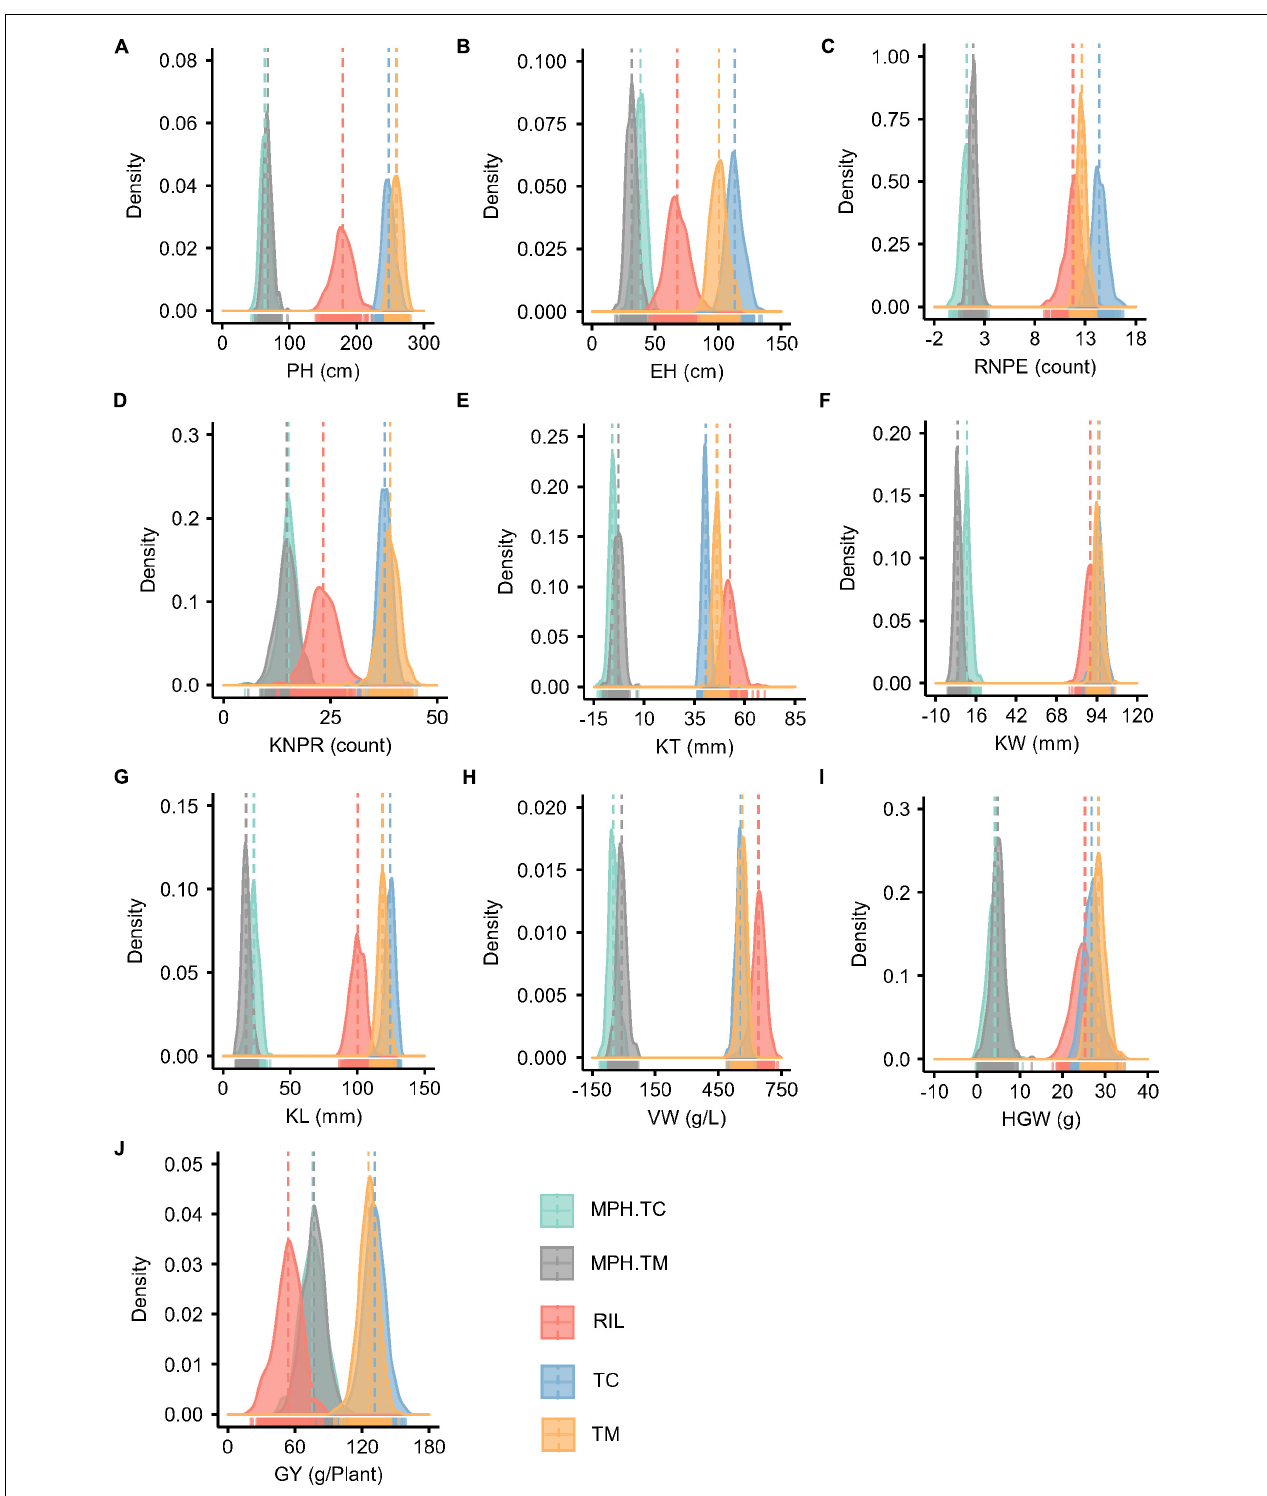
FIGURE 1 | Phenotype and midparent heterosis (MPH) distributions for 10 traits in the recombinant inbred line population developed by Ye478 × Qi319 (RIL), Chang7-2 × RIL (TC), and Mo17 × RIL (TM) populations. (A) PH, plant height; (B) EH, ear height; (C) RNPE, row number per ear; (D) KNPR, kernel number per row; (E) KT, kernel thickness; (F) KW, kernel width; (G) KL, kernel length; (H) VW, volume weight; (I) HGW, hundred grain weight; (J) GY, grain yield per plant; MPH.TC, MPH in TC population; MPH.TM, MPH in TM population.